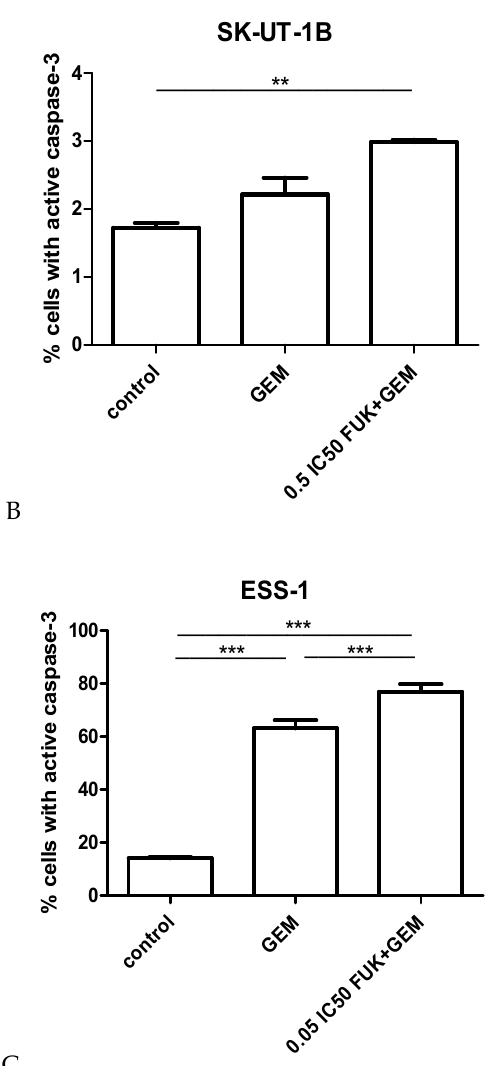
Figure 6. Effects of gemcitabine (in IC 50 concentration) and mixture of fucoidan and gemcitabine (in concentrations of 0.5 IC 50 for SK-UT-1 and SK-UT-1B and 0,05 IC50 for ESS-1) on caspase-3 activation in SK-UT-1 ( A ), SK-UT-1B ( B ), and ESS-1 ( C ) cells. Results are expressed as mean ± SD of three separate experiments (* p < 0.05, ** p < 0.01, *** p < 0.001 versus the control, one-way ANOVA test).